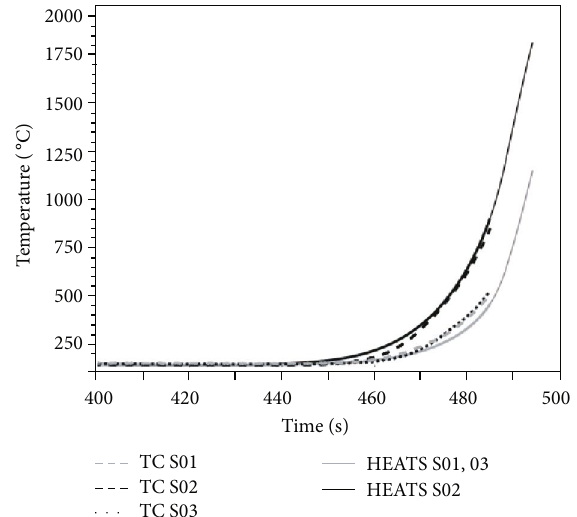
Figure 21: Detailed view of the atmospheric return fl ight phase of the SHEFEX II trajectory compared to prediction by